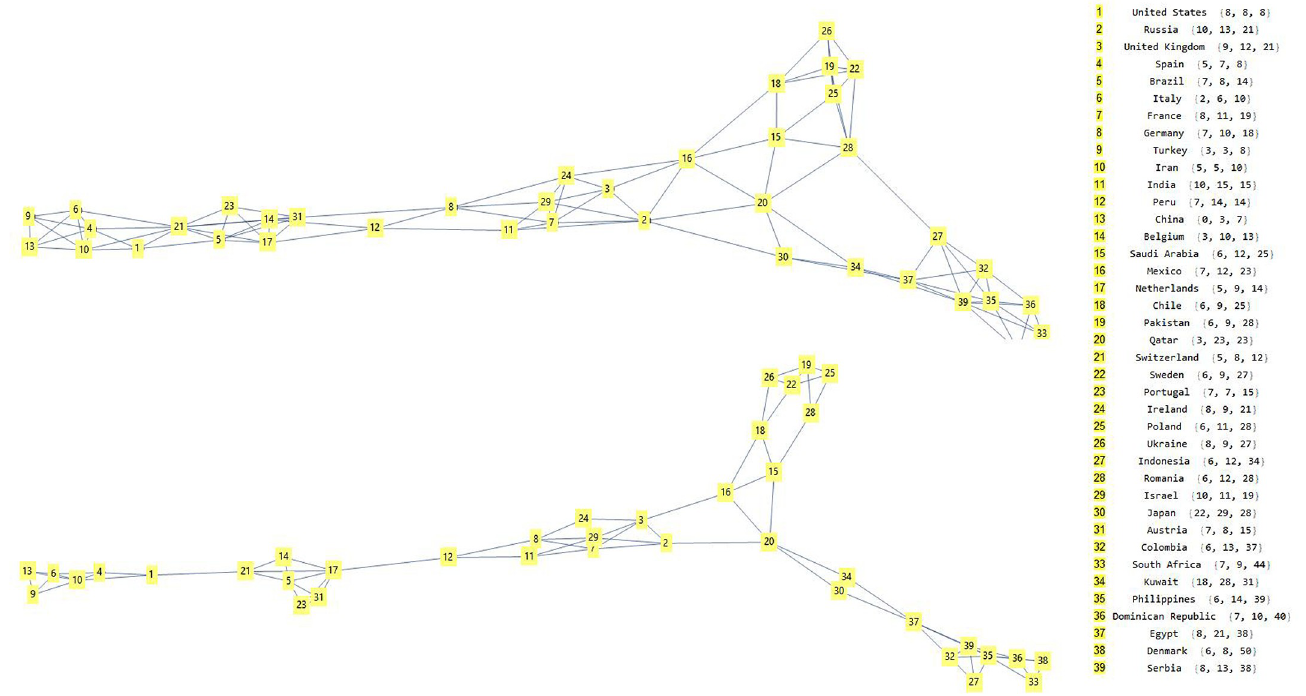
Fig 11. Complex graph representations of the 39 countries, with different temporal interval. In Fig 11(a), it is possible to see a graph, with the names of the 39 countries, by considering 4 neighbouring countries; in Fig 11(b), a disconnected graph, when instead we consider 3 neighbouring countries. This demonstrate how countries can be connected together. This method can be useful to detect mutual relationships among countries that share similar temporal intervals.